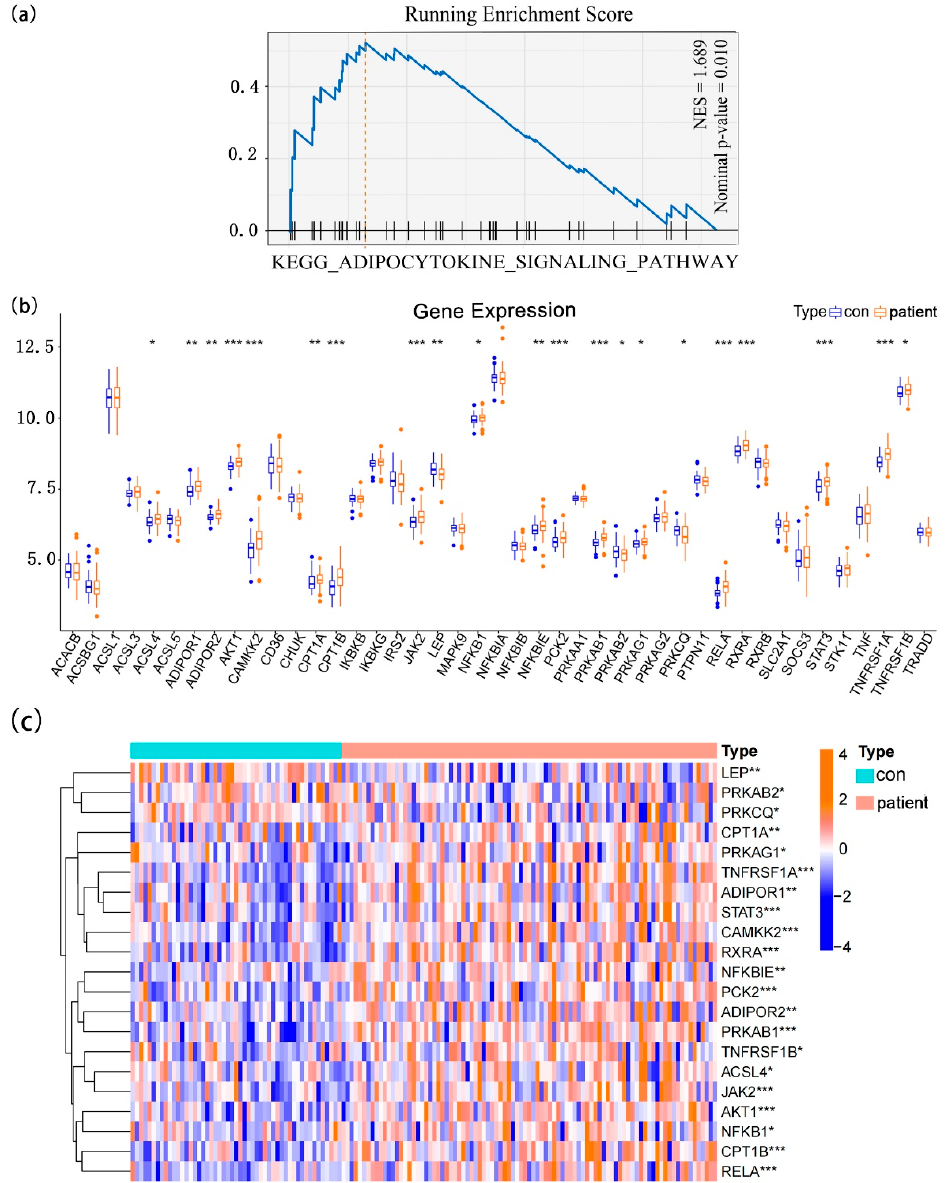
(Figure 3d), 21 adipocytokine pathway-related genes were arranged in sequence according to the value of the “Mean Decrease Gini”. Since the stability of the RF model increases as the Gini index decreases, the five most pivotal genes (RELA, PRKAB1, TNFRSF1A, CAMKK2, and CPT1B) were selected as a diagnostic signature to plot a nomogram. Furthermore, we found that antiepileptic drug treatment did not affect the expression of these five genes (Figure S1).